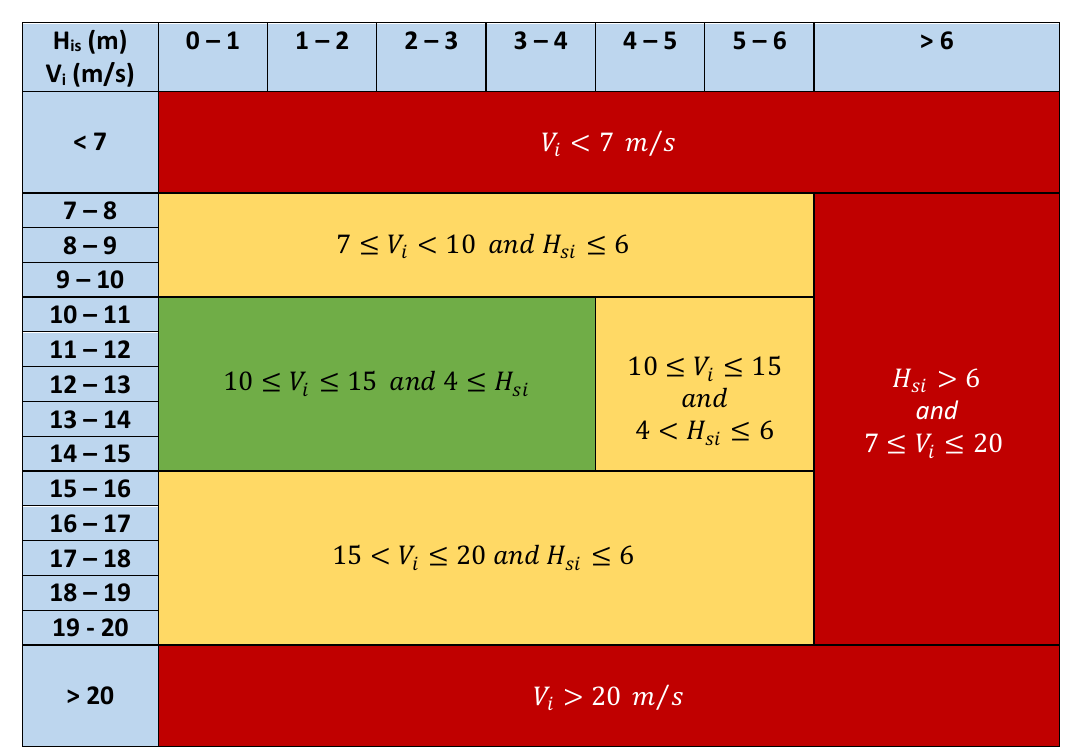
Figure 5. Selected operability ranges. Green: optimal, yellow: sub-optimal, red: non-operative.